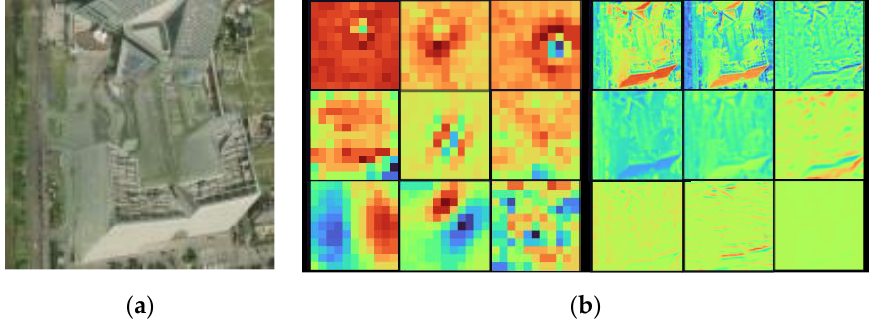
Figure 3. Schematic of convolutional kernel spatial information ranking.